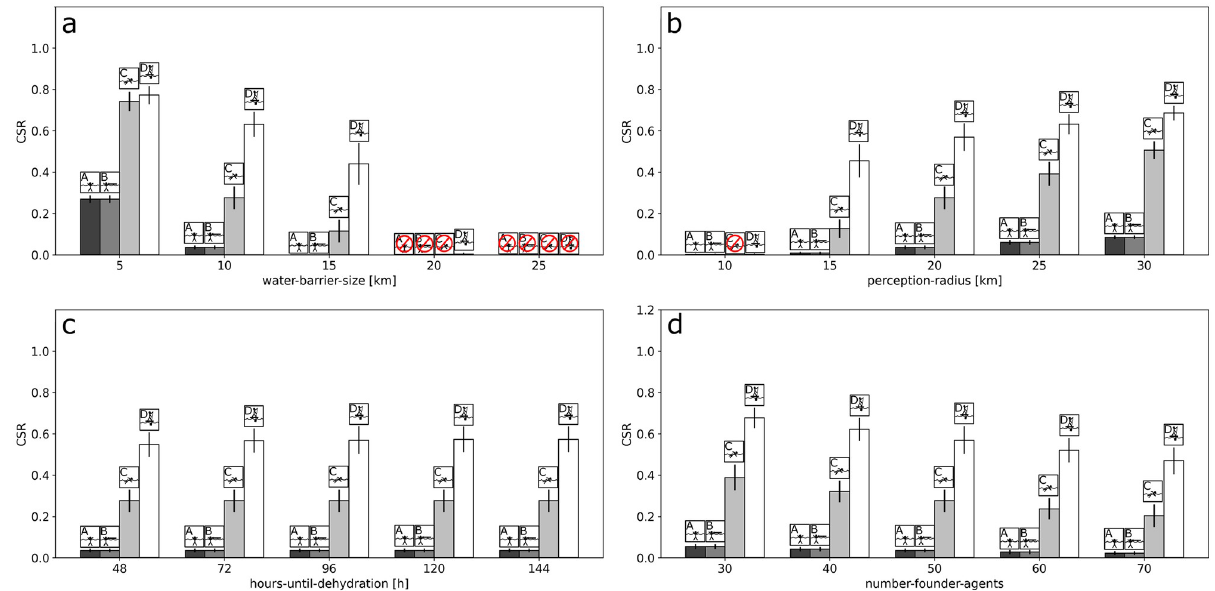
Fig 5. One-factor sensitivity with respect to average CSRs. The one-factor sensitivity experiments show how the systematic variation of levels of a single factor affect the average CSR response. Results are shown for water-barrier-size (a), perception-radius (b), hours-until-dehydration (c) and number-founder-agents (d). The behavioral scenarios are represented by the icons. Crossed out red circles indicate no successful crossing (CSR = 0).